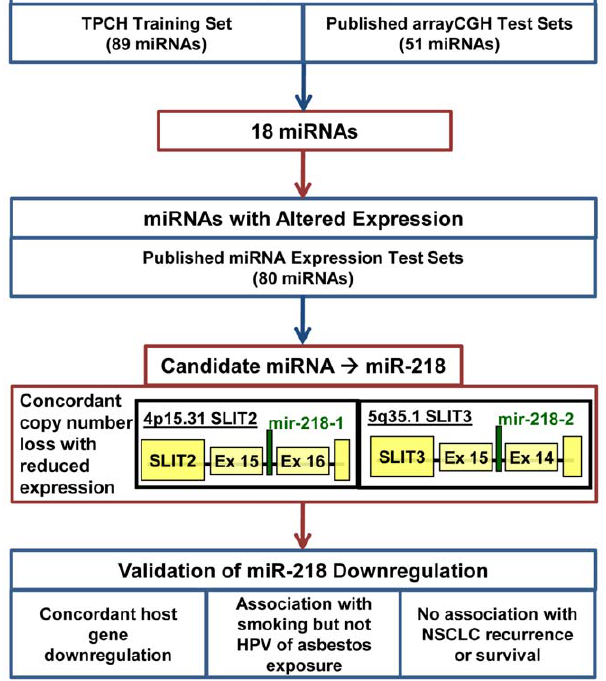
Figure 1. Identification of miR-218 from concordant copy number variation and gene expression from independent data sets. Expression levels of 38/89 candidate miRNAs and 19/51 published arrayCGH miRNAs have not been studied due to their recent inclusion in miRBase. The genomic location of miR-218 within its two host genes, SLIT2 and SLIT3, is also illustrated.